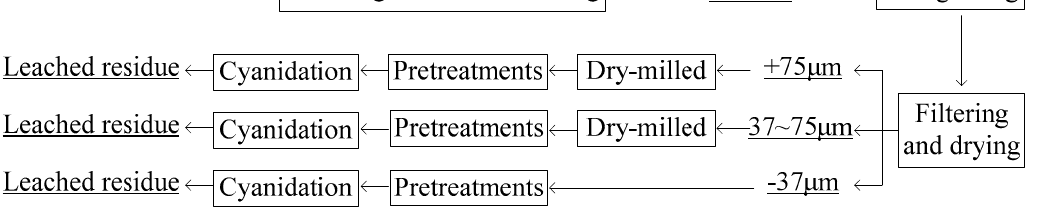
Figure 1. Simplified flow chart of the manipulations.